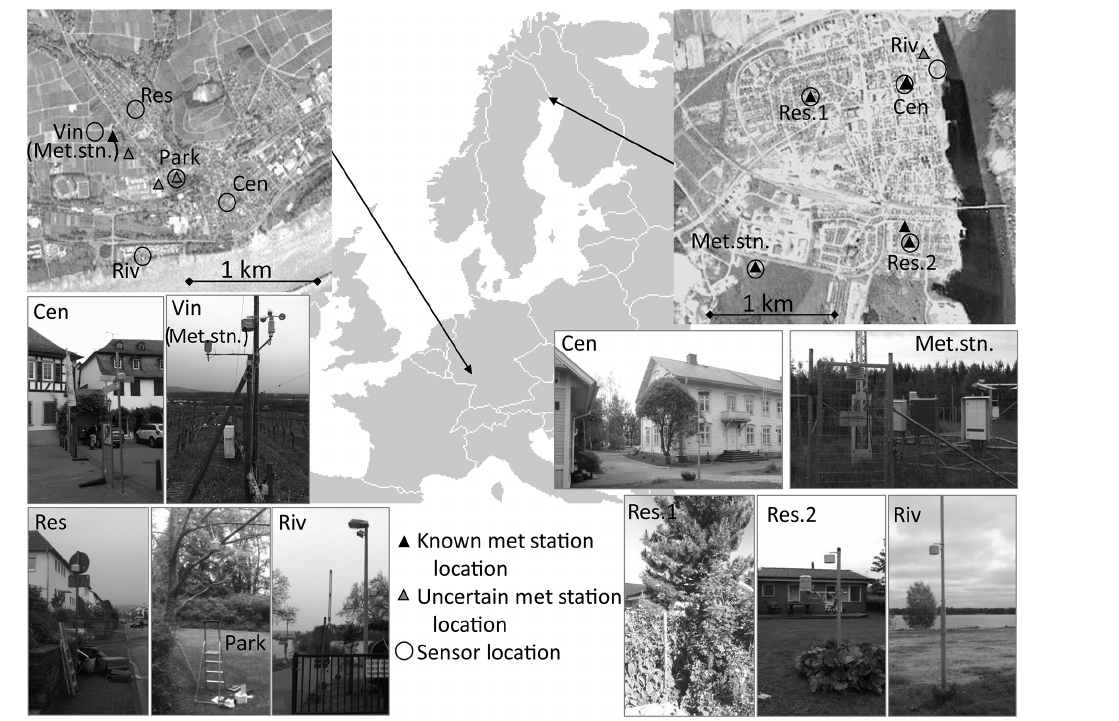
Figure 1. Location of the met stations and temperature sensors in Geisenheim (left panels) and Haparanda (right panels): previous (triangles) and current (black location known, grey location uncertain or has changed substantially since station was located there), circles mark sensor locations. Photos show locations of sensors used in this study. Satellite images from Google